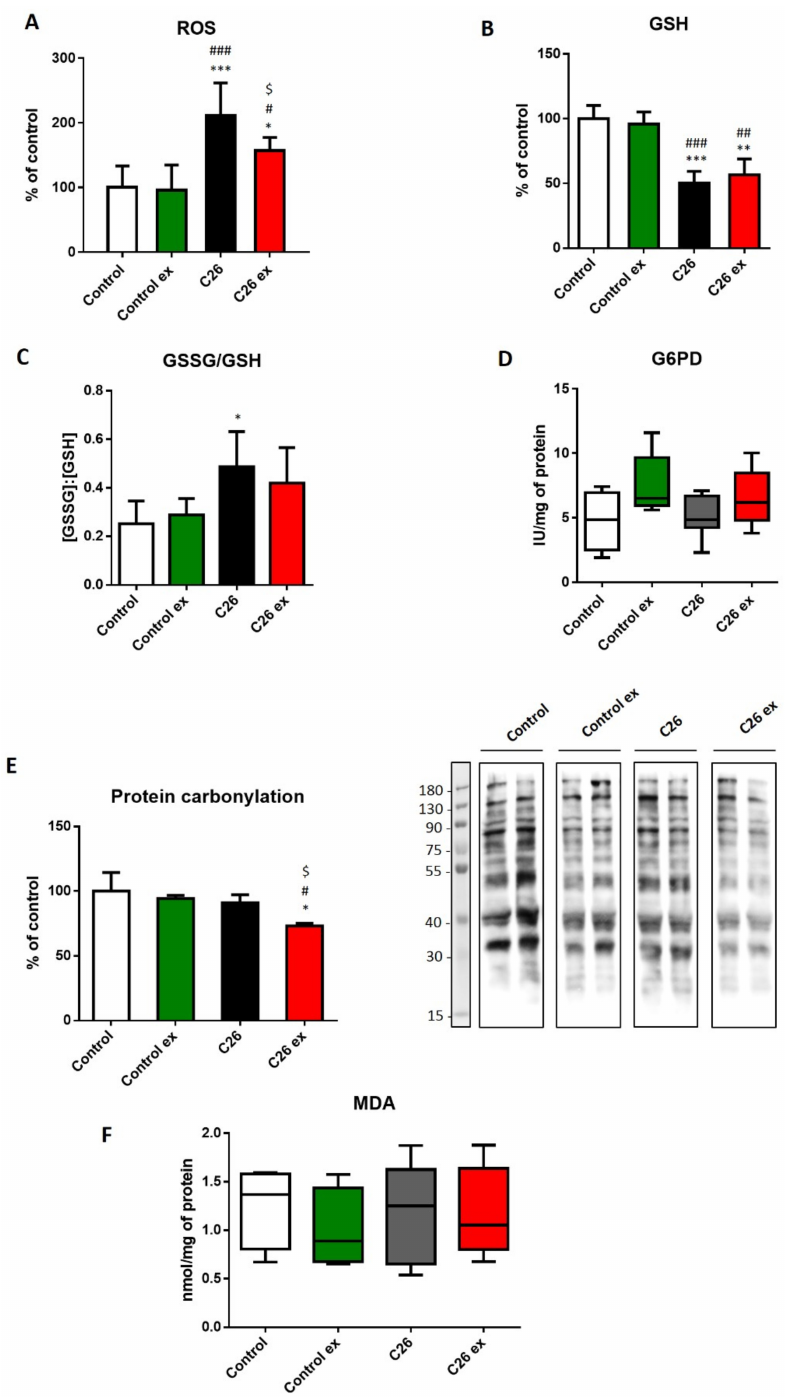
Figure 3. Tumor-bearing mice show a redox imbalance that is partially corrected by exercise. ROS levels ( A ), GSH levels ( B ), GSSG/GSH ratio ( C ), G6PD enzymatic activity ( D ), protein carbonylation ( E ; representative blot and quantification) and MDA levels ( F ) of control ( n = 5), control exercised (control ex; n = 6) and tumor-bearing mice either sedentary (C26; n = 8) or exercised (C26 ex; n = 8). ROS, GSH and protein carbonylation levels (means ± SD) are expressed as percentage of control. GSSG/GSH data (means ± SD) are expressed as the ratio of GSSH and GSH concentrations. G6PD activity (median and min to max whiskers) is expressed as specific activity. MDA levels (median and min to max whiskers) are expressed as nmol/mg protein. Significance of the differences: * p < 0.05, ** p < 0.01, *** p < 0.001 vs. control; # p < 0.05, ## p < 0.01, ### p < 0.001 vs. control ex; $ p < 0.05 vs.